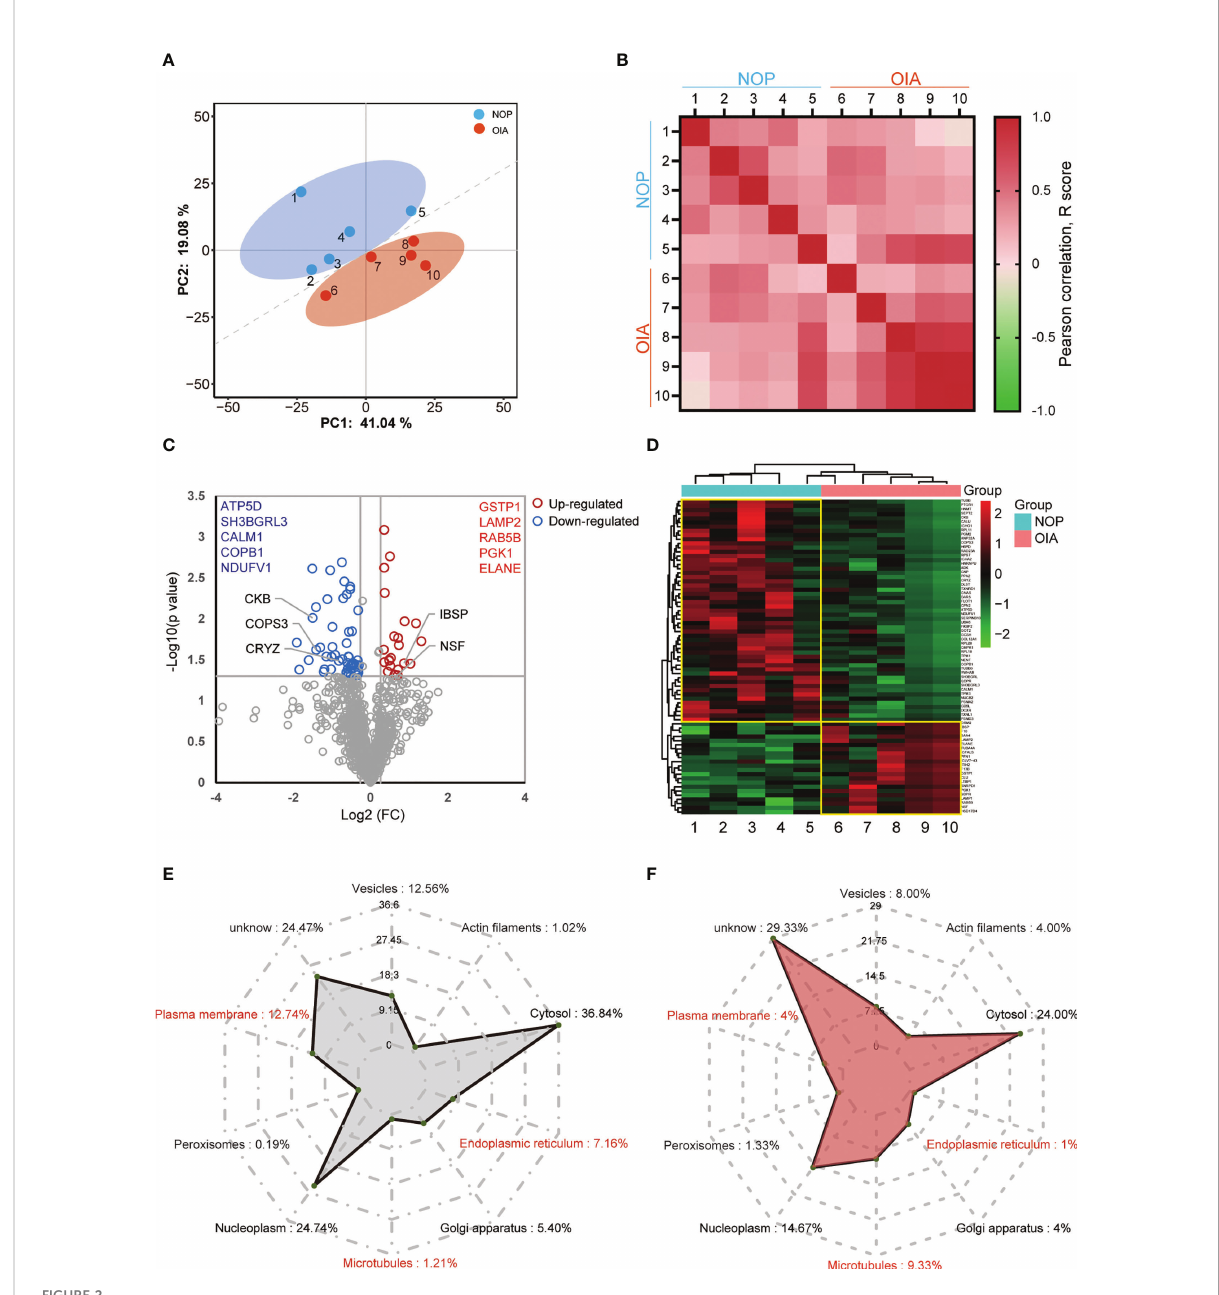
FIGURE 2 Quantitative proteomics analysis of human bone from osteoporosis patients with iron accumulation. (A) Principal component analysis (PCA) plot showing unsupervised clustering among the 10 samples, demonstrating clear distinction between two Groups. (B) Pearson correlation analysis of proteomic data from 10 samples. (C) Volcano plots comparing bone proteome of Group NOP and OIA. (D) Heatmap and cluster of the differentially expressed proteins. (E, F) Subcellular localization chart of NDEPs (E) and DEPs (F) . The amount of protein in each section is expressed as a